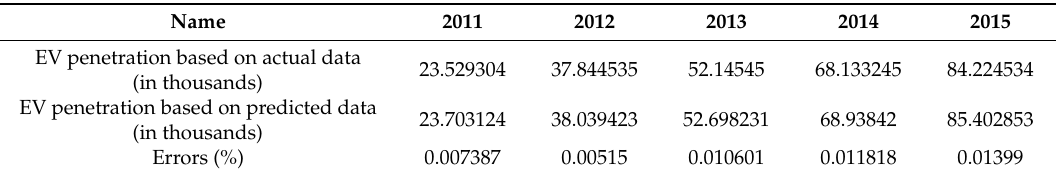
Table 7. The compared results between actual data and predicted data.